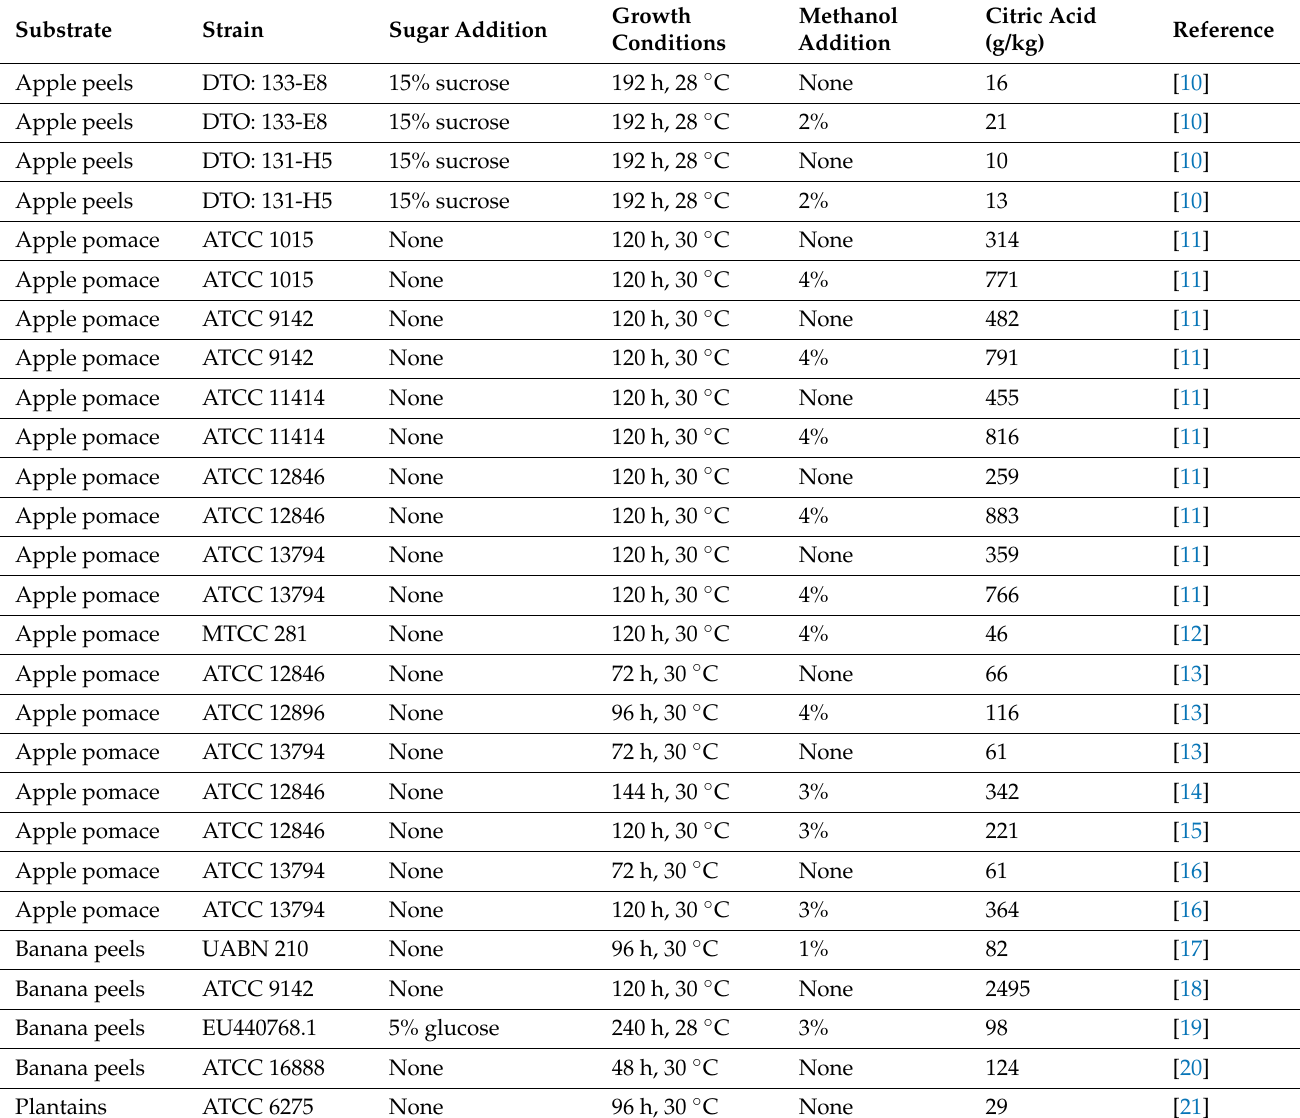
Table 1. Growth conditions and maximum citric acid production by Aspergillus niger strains on processing wastes of apples, bananas and plantains using solid-state